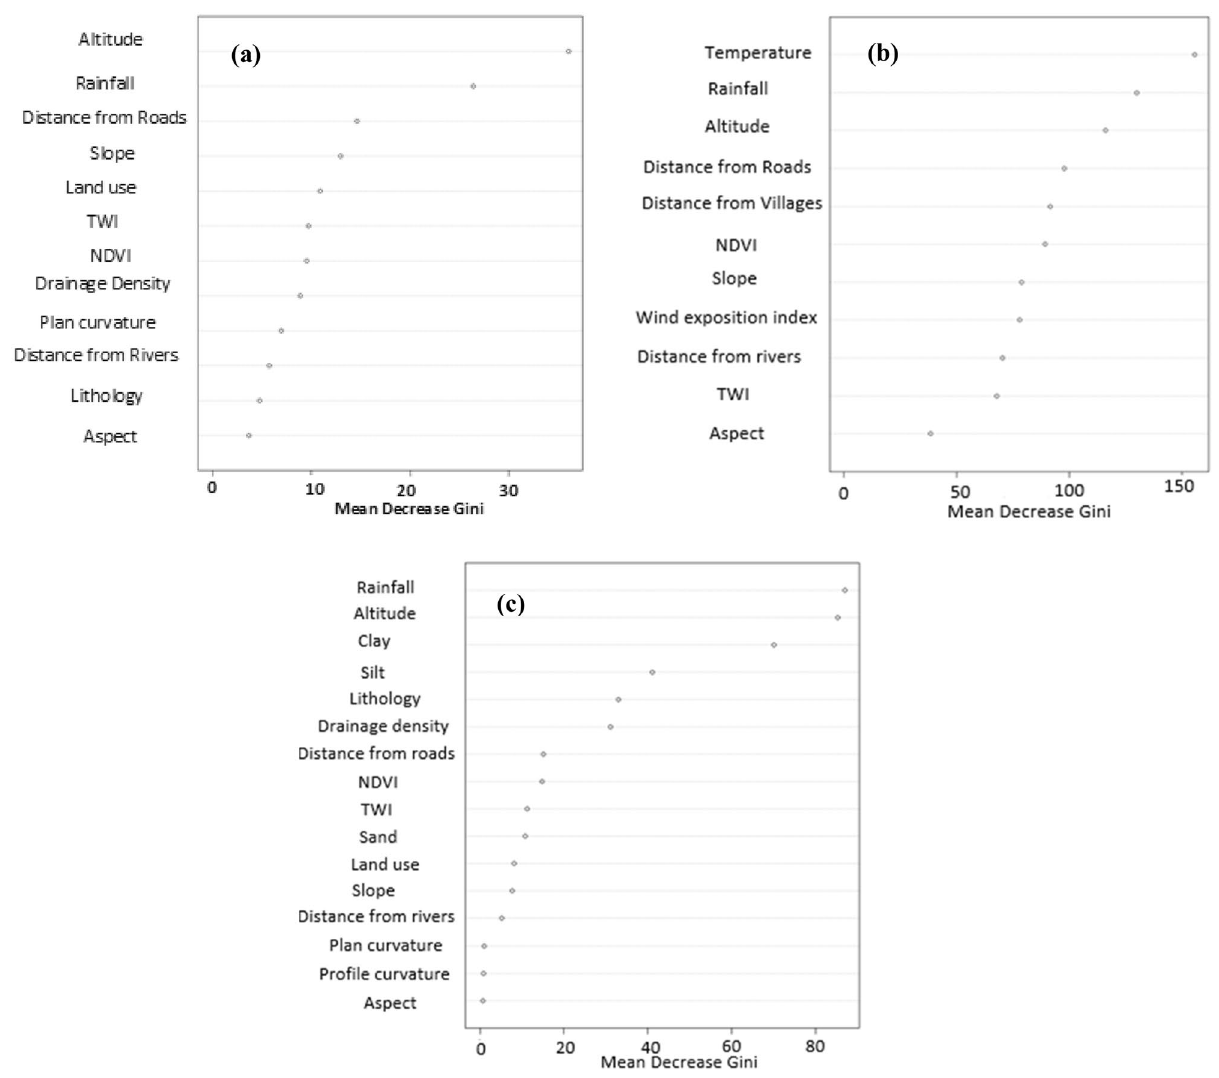
Figure 1. Priority of the effective factors for each